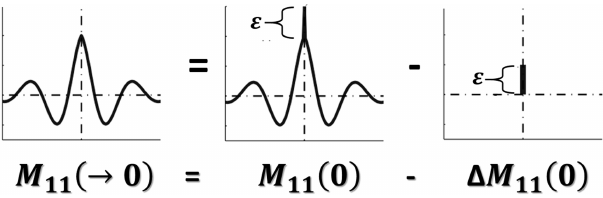
Figure 1. Procedure to remove the errors of autocovariance functions. M 11 ( → 0 ) is corrected autocovariance function errors, M 11 (0) is autocovariance function without correction and (cid:49)M 11 (0) is error of autocovariance